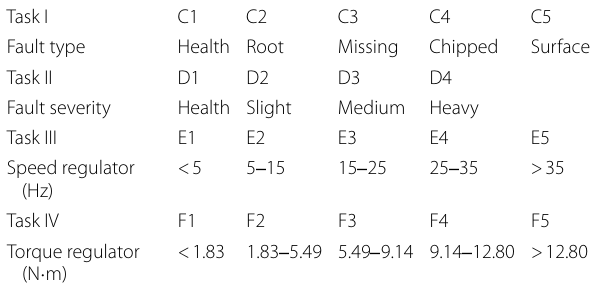
Table 3 Define levels in different tasks